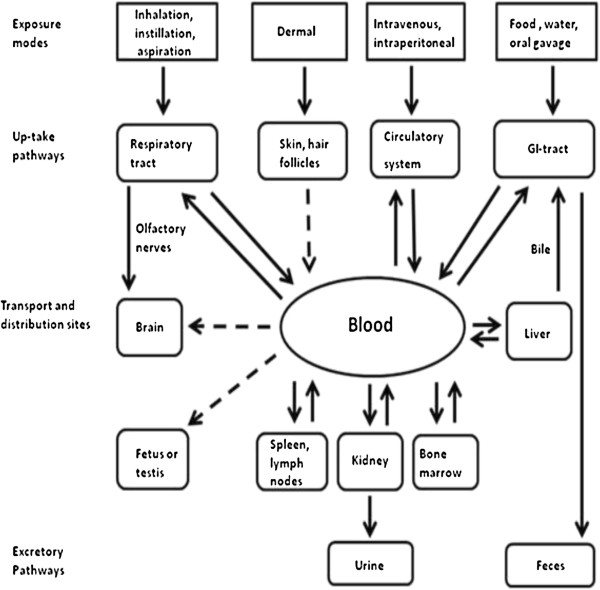
Toxicokinetics and accumulation sites of TiO2 NPs. The arrows in dotted lines represent uncertainties.